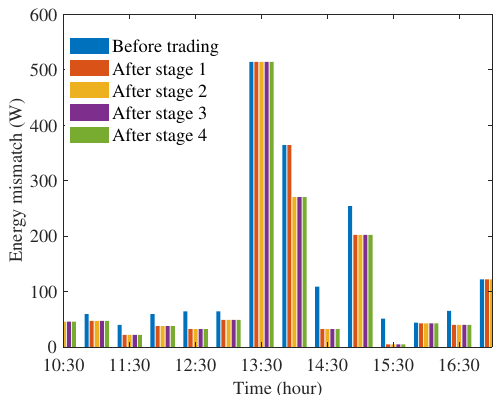
Figure 5. Energy mismatch at house 1 in the microgrid with no energy trading and after different stages of energy trading.